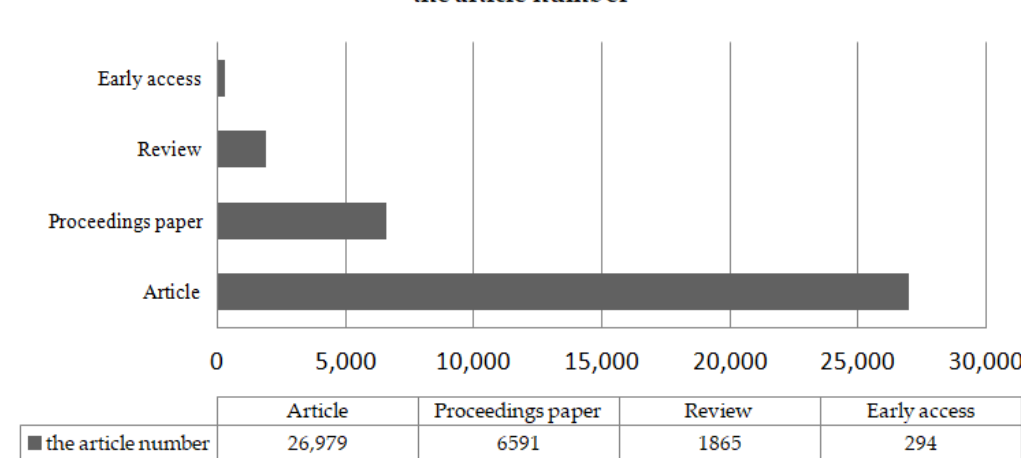
Figure 3. Type of SCI papers published on link prediction.